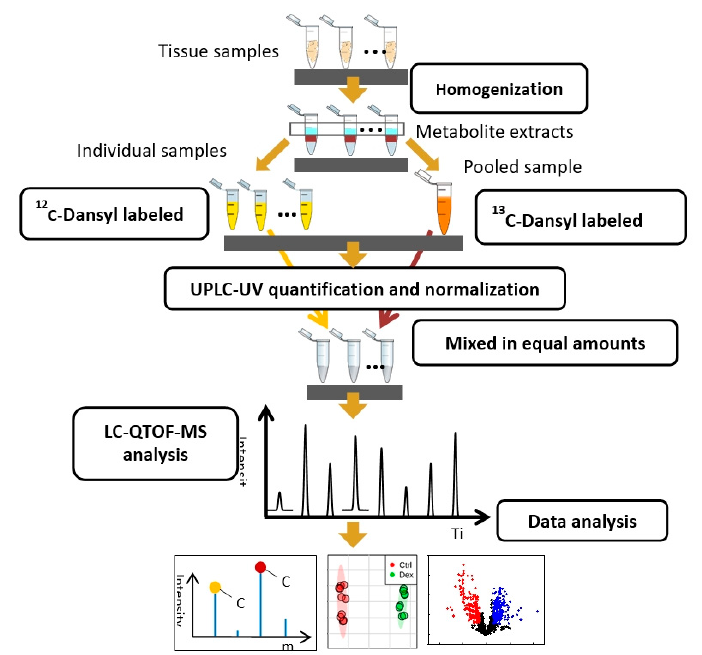
Figure 8. Workflow followed in the metabolomics profiling of rat tissues collected from five organs (different types of tissues were profiled separately). After 14 weeks of twice ‐ weekly treatment of Sprague–Dawley rats with Dexamethasone (Dex), the amine/Phenol sub ‐ metabolomes of freshly collected tissue samples from five major body organs were studied using chemical isotope labeling liquid chromatography ‐ mass spectrometry. The metabolite profile was compared for the untreated control and Dex ‐ treated groups for each studied organ.